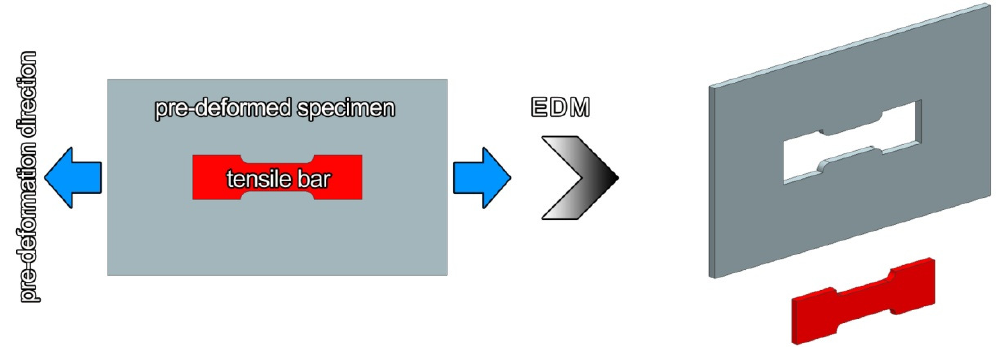
Figure 1. A schematic illustrating the preparation of tensile bar.